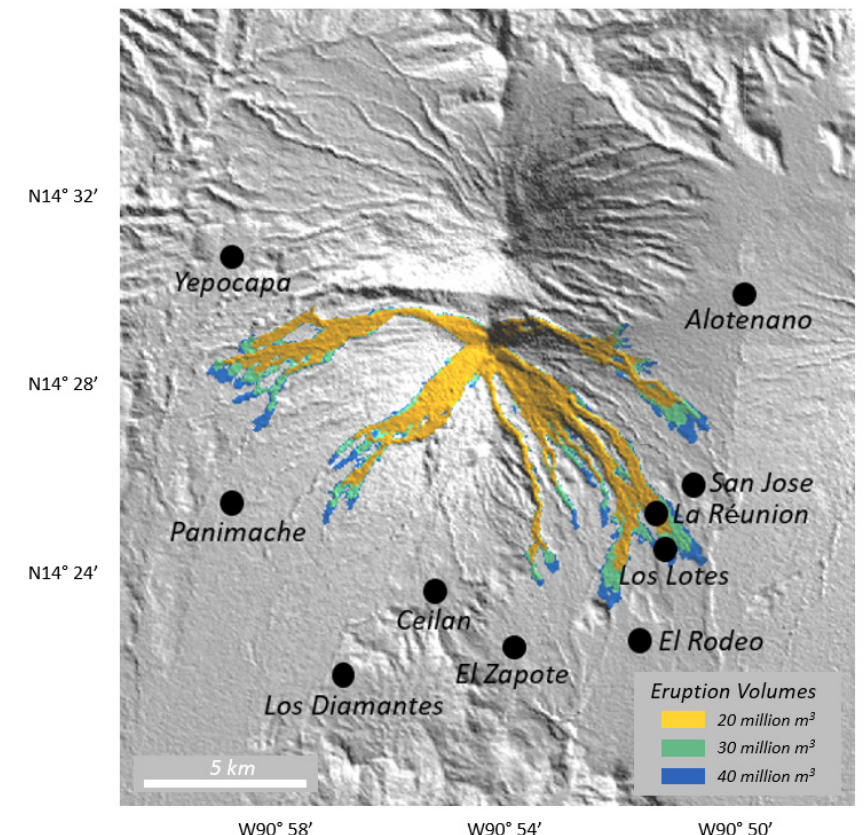
Figure 8. Inundation PDC hazard map for Fuego created using VolcFlow and the ASTER GDEM. Each color represents a di ff erent PDC volume. The PDCs tend to follow the topographic lows (barrancas) with only minor deviations. Population centers that could possibly be impacted by future larger PDC events are identified. The inundation PDC hazard map indicates that both Los Lotes and La R é union were at risk from a PDC with a volume similar to the estimate for the 3 June